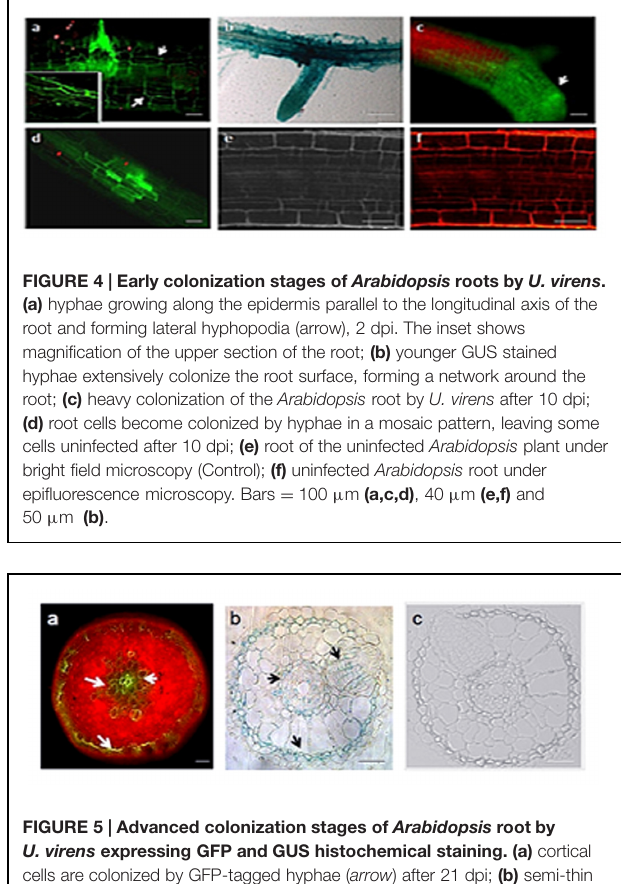
observed in the cross-section of the uninfected Arabidopsis root ( Figure 5c